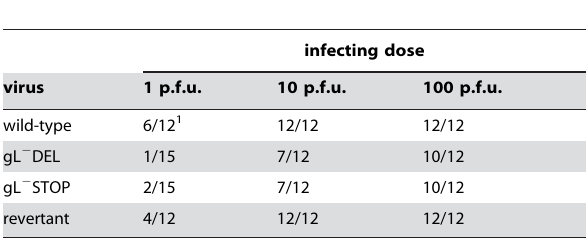
Table 1. Low dose in vivo infection by gL + and gL 2 MuHV-4.